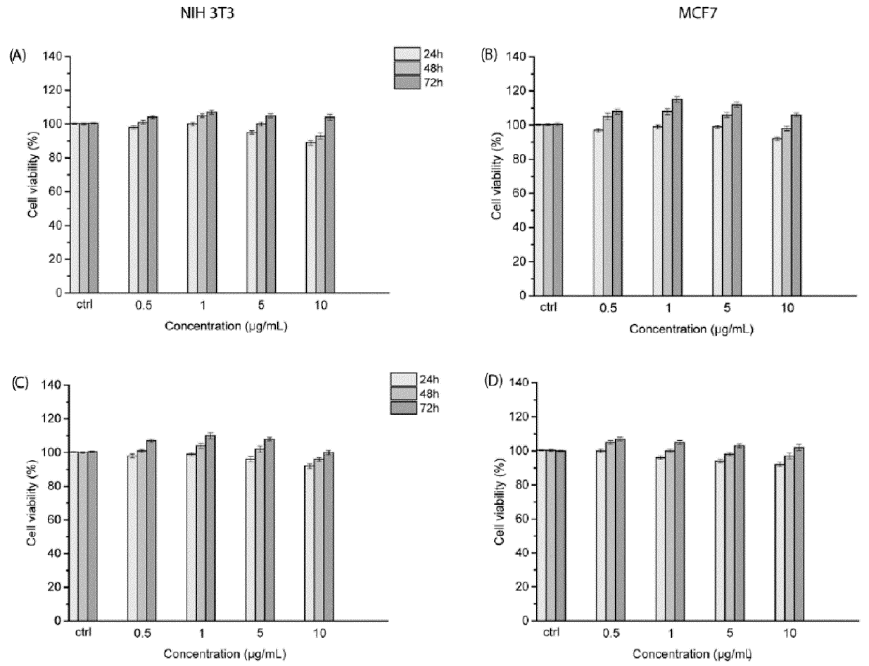
Figure 6. Cellular viability of NIH 3T3 and MCF7 cells treated with various concentrations of BN- ( A , B ) and oxi-BN-CNOs ( C , D ) for 24, 48, and 72 h. Data are expressed as mean ± standard deviations of three replicates.